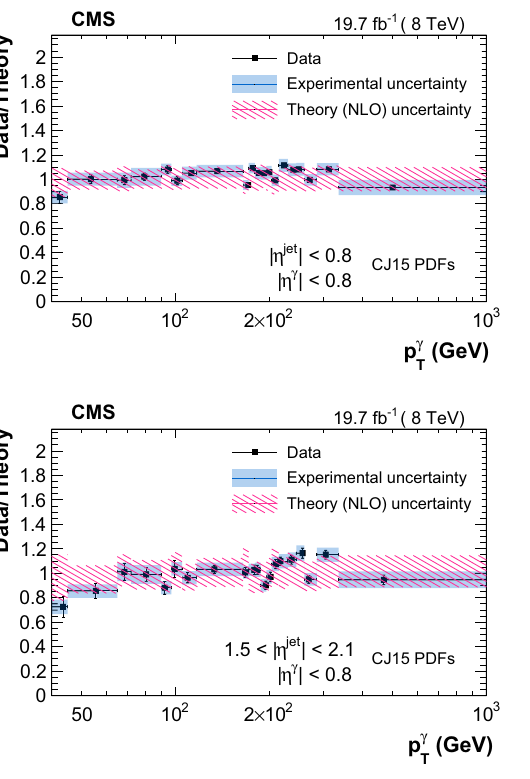
γ | η γ | < 0 . 8. Error bars on the data are statistical uncertainties, and blue T bands represent the systematic